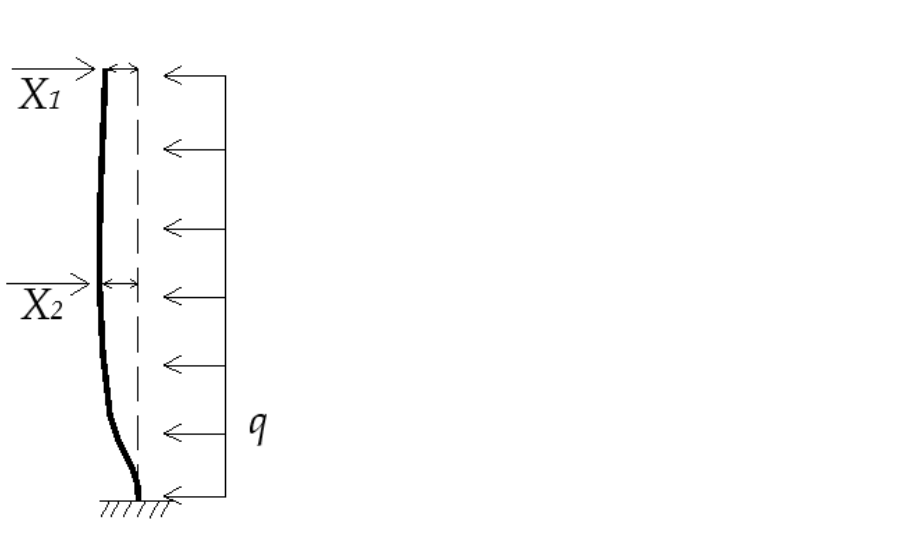
Figure 9. Basic structure of force method under uniformly distributed load of wall column.